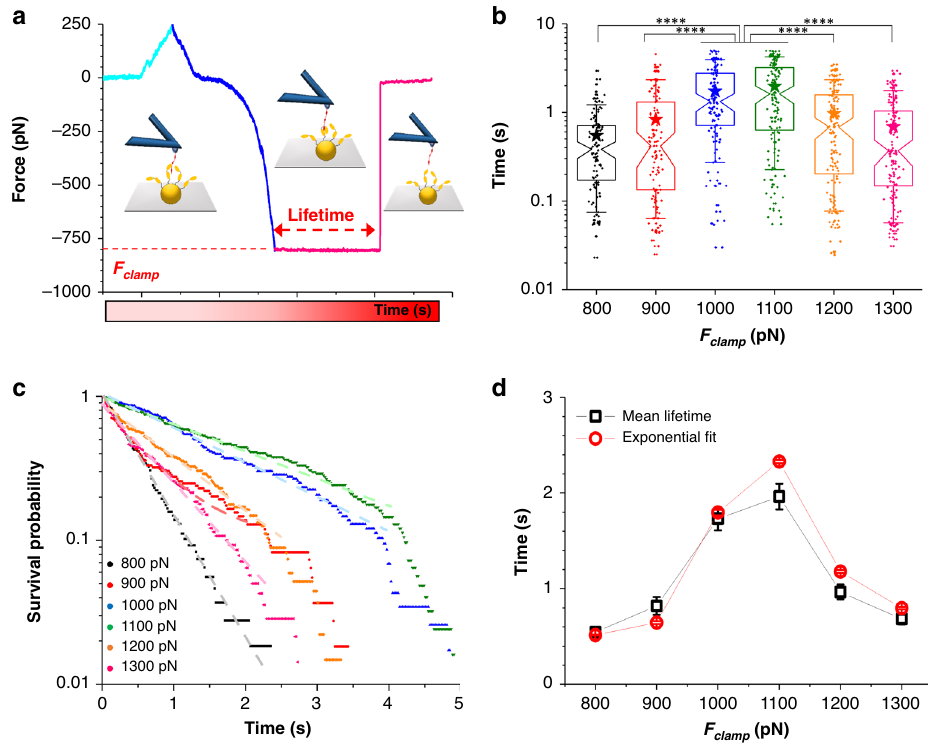
Fig. 4 The DLL-interaction between SpsD and fi brinogen involves a catch-slip bond transition. ( a ) Characteristic force – clamp curve (force vs time) along with illustrations of the setup at different steps of the clamp process. Cyan stands for the approach, blue for the retraction, and pink for the clamp and spontaneous rupture of the SpsD- fi brinogen bond. The bond lifetimes is given by the constant force regime in red. ( b ) Box plot (overlapped with data, n = 108, 109, 116, 124, 135, and 140 for F clamp = 800, 900, 1000, 1100, 1200, 1300 pN, respectively, recorded on 11 cells from 6 independent cultures) of the lifetimes extracted from the force vs time curves at a retraction velocity of 1000 nm s − 1 . Stars are the mean values, boxes the 25 – 75% quartiles and whiskers the 10 – 90% interval. Kruskal – Wallis test followed by Dunn ’ s multiple-comparison test: **** p ≤ 0.0001. ( c ) Bond survival probabilities for the SpsD – Fg interactions, measured at six different clamping forces. Fits are presented as dashed lines with corresponding colors. ( d ) Force-dependent bond lifetimes, extracted from the exponential fi t on the survival plot and the average lifetimes from the box plot, at a retraction velocity of 1000 nm s − 1 , exhibit a catch-slip transition. For average lifetimes, error bars represent the standard deviation from n = 108, 109, 116, 124, 135, and 140 data points for F clamp = 800, 900, 1000, 1100, 1200, 1300 pN, respectively, on 11 cells from 6 independent cultures (as in ( b )). For lifetimes extracted from the exponential fi t, error bars stand for the standard error of the fi